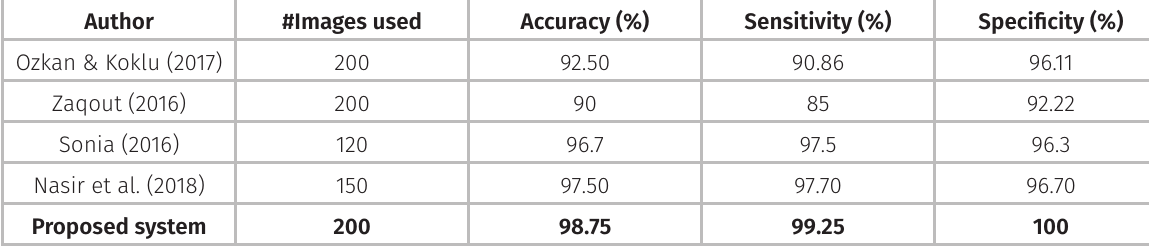
Table IV. Comparison of BT and SVM based SCC system results with existing systems